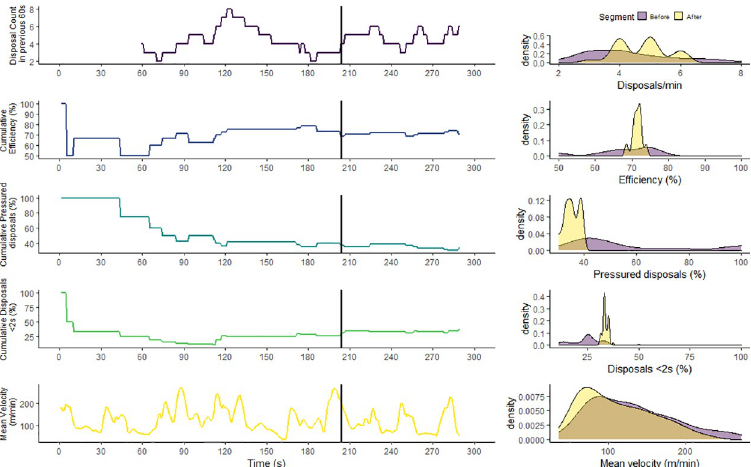
distribution of the feature in each segment, before and after the changepoint.